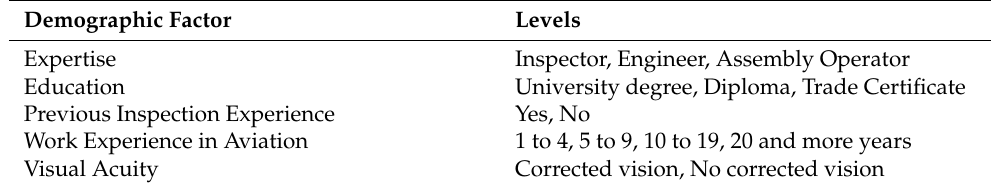
Table 1. Overview of demographic factors and levels